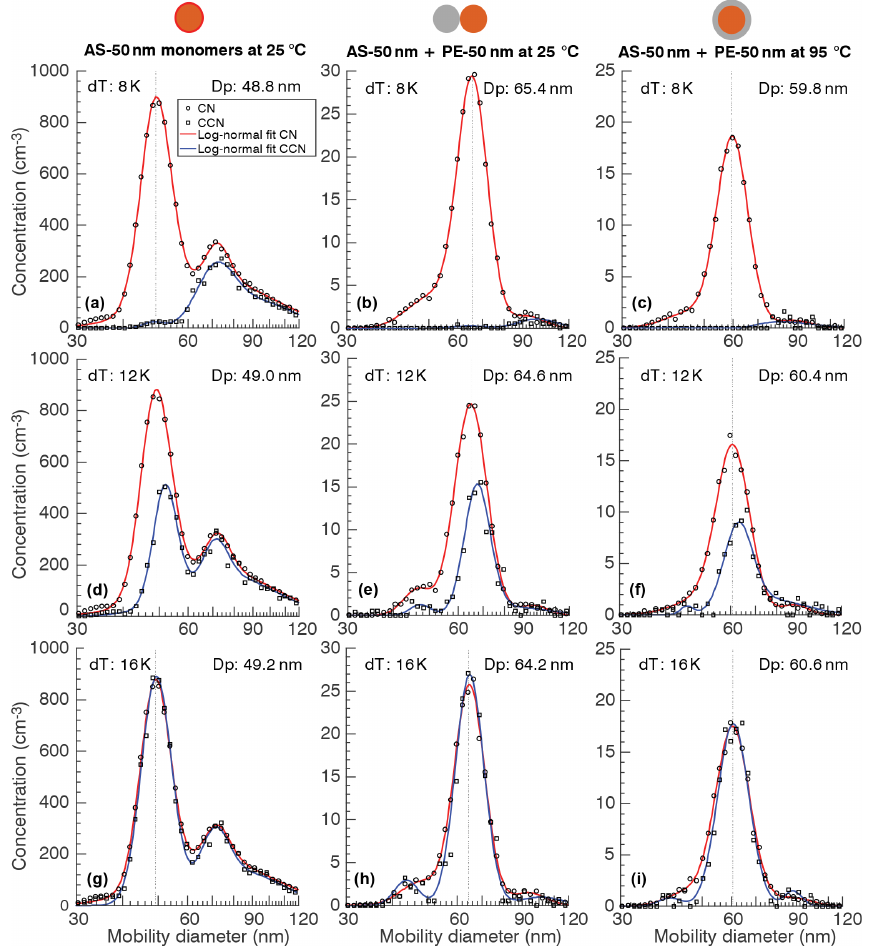
Figure 3. CN and CCN size distributions at three different CCNc column temperature gradients corresponding to water supersaturations measured after the thermal conditioning of